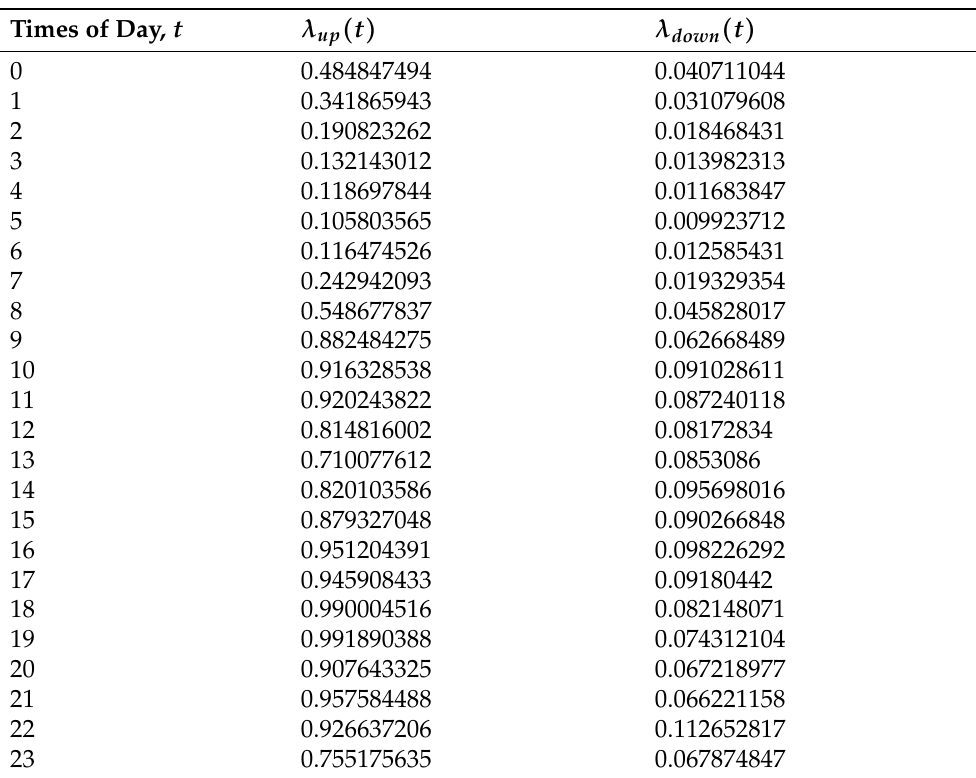
Table 4. Dependence of the number of requests on the time of day.